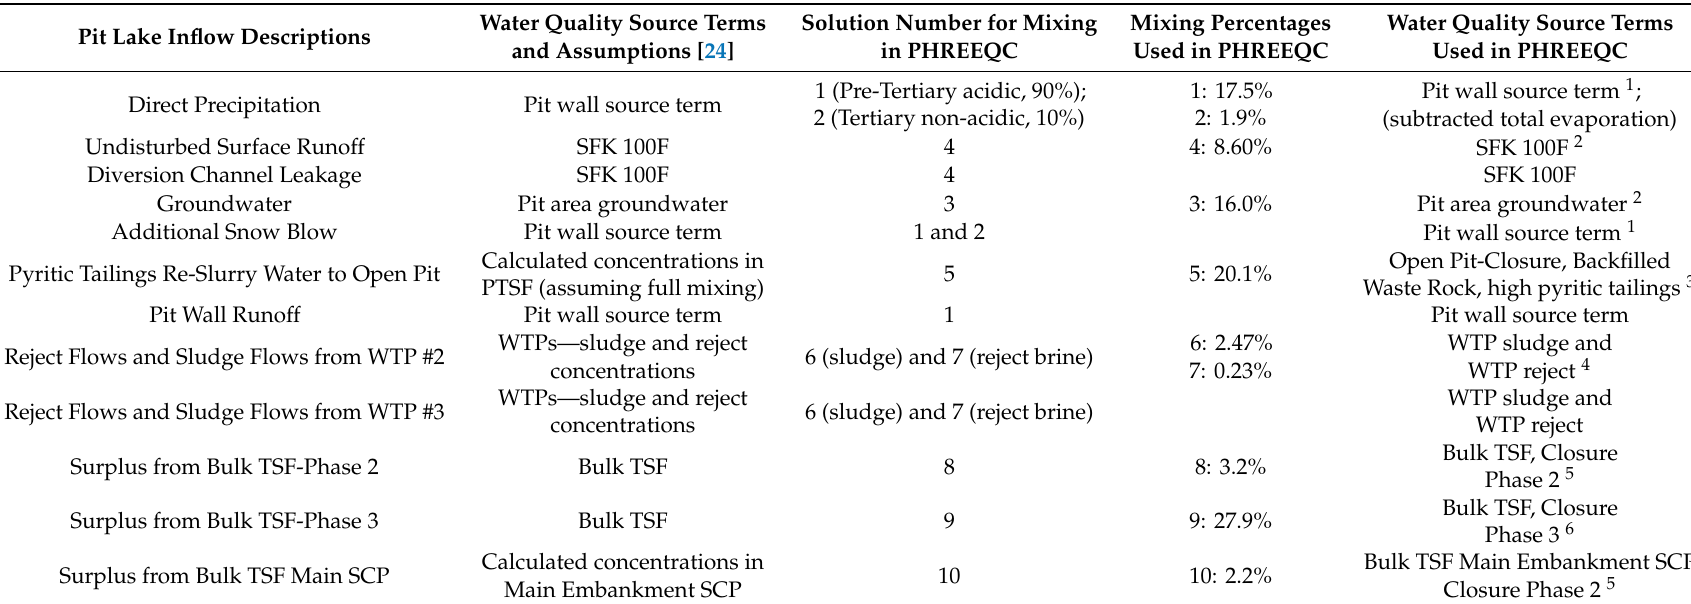
Table 1. Water quality source terms and volume percentages used for mixing in